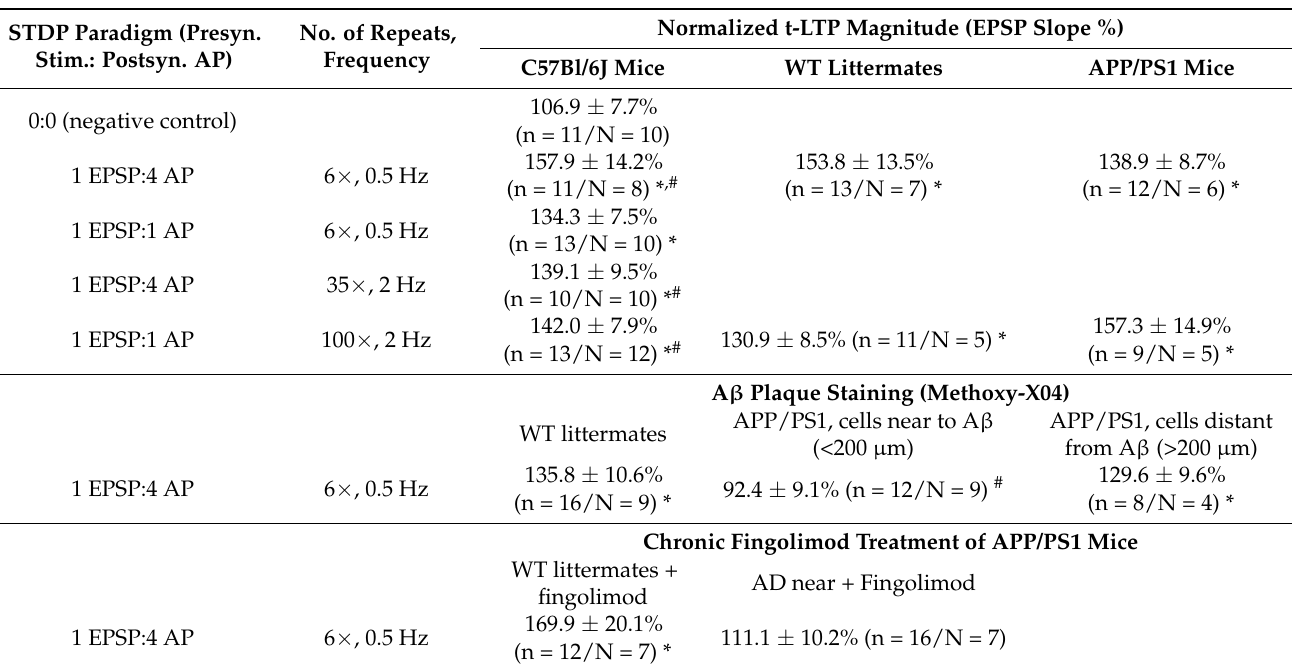
Table 1. Summary of different STDP paradigms induced t-LTP at the hippocampal SC-CA1 synapses in 6-month-old C57Bl/6J and APP/PS1